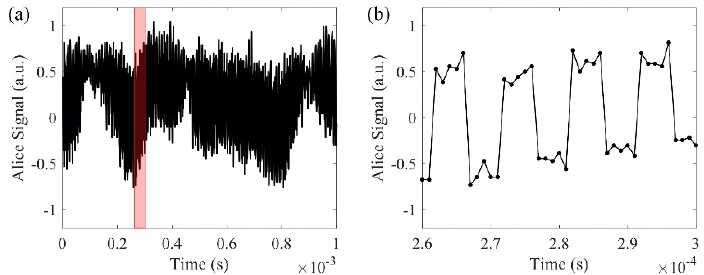
Figure 6. ( a ) and ( b ) are signals with phase modulator; ( b ) is the enlarged view of the red region in ( a ).